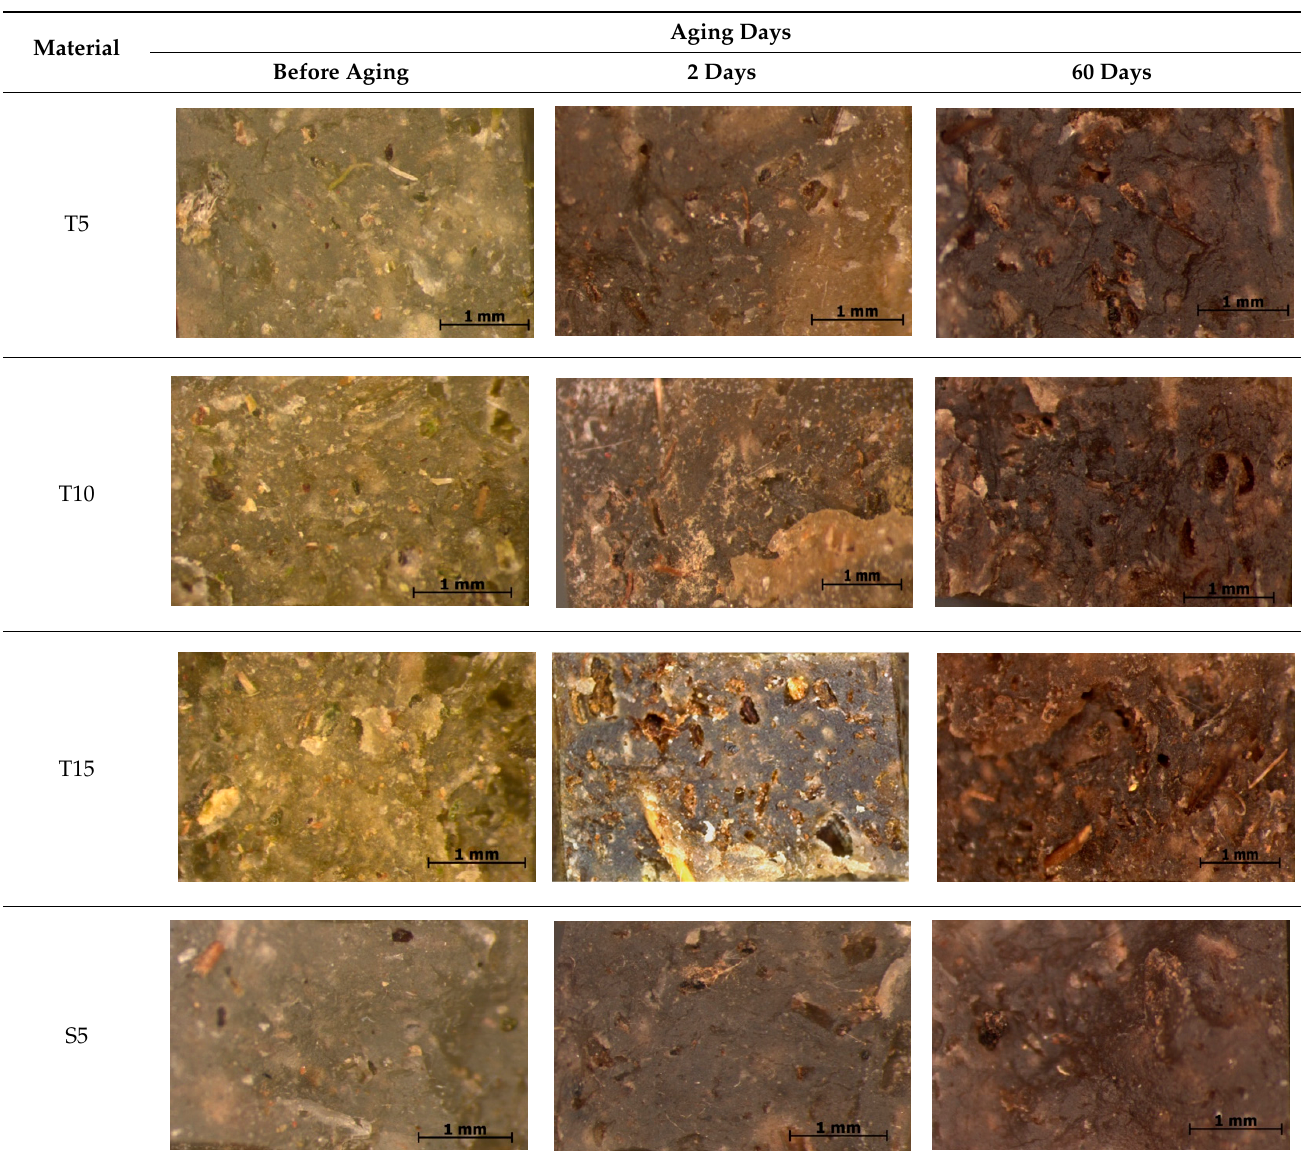
Table 5. Cross section of composites’ samples.